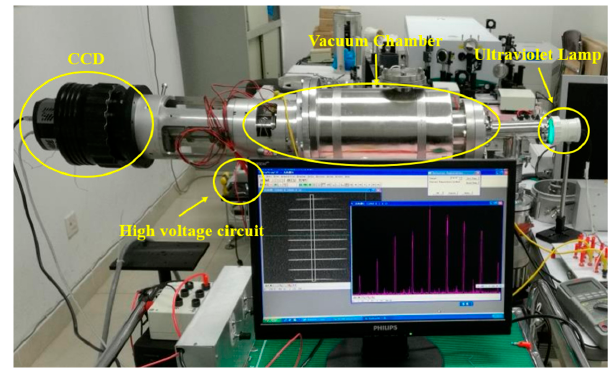
Figure 5. Experimental test platform and streak tube.